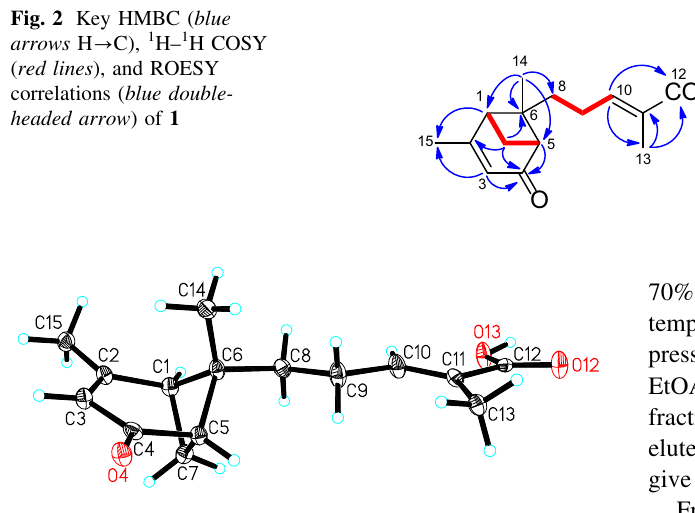
Fig. 3 X-ray structure of